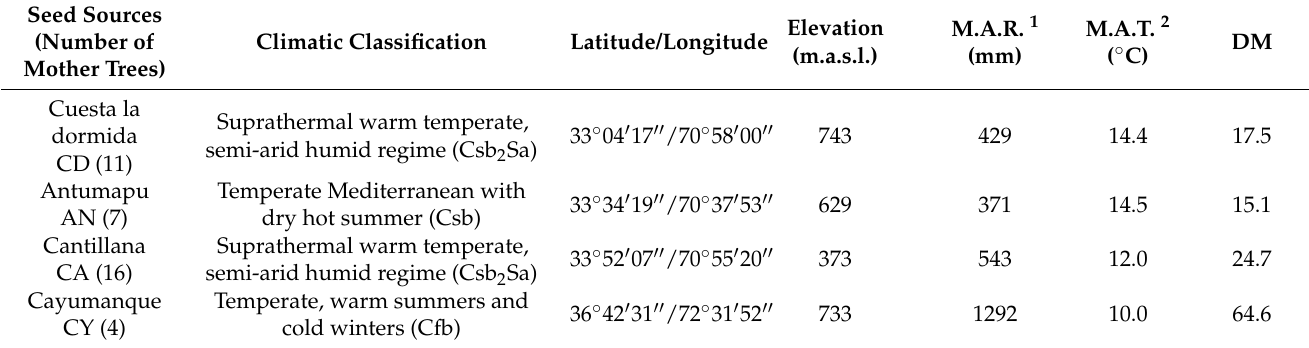
Table 3. Climatic and geographic data for seed sources Cuesta La Dormida (CD), Antumapu (AN), Cantillana (CA) and Cayumanque